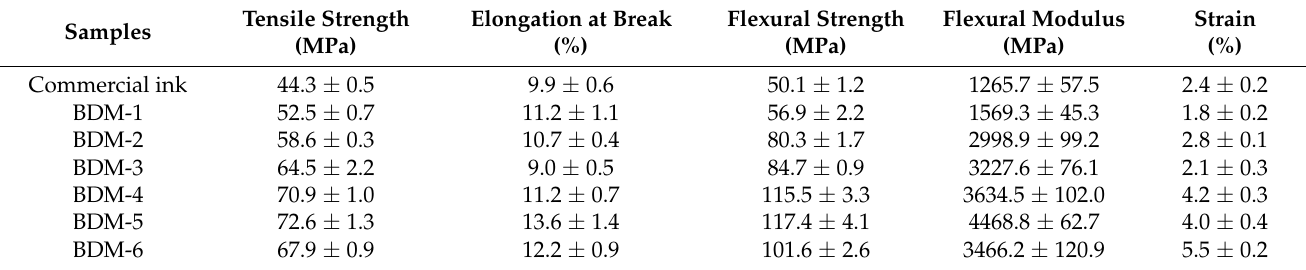
Figure 3. ( a ) Tensile and ( b ) flexural strength versus strain curves of 3D-printed samples obtained from commercial ink and BDM inks. Table 3. Results of tensile and flexural tests for three-dimensional (3D)-printed samples obtained from commercial and BDM